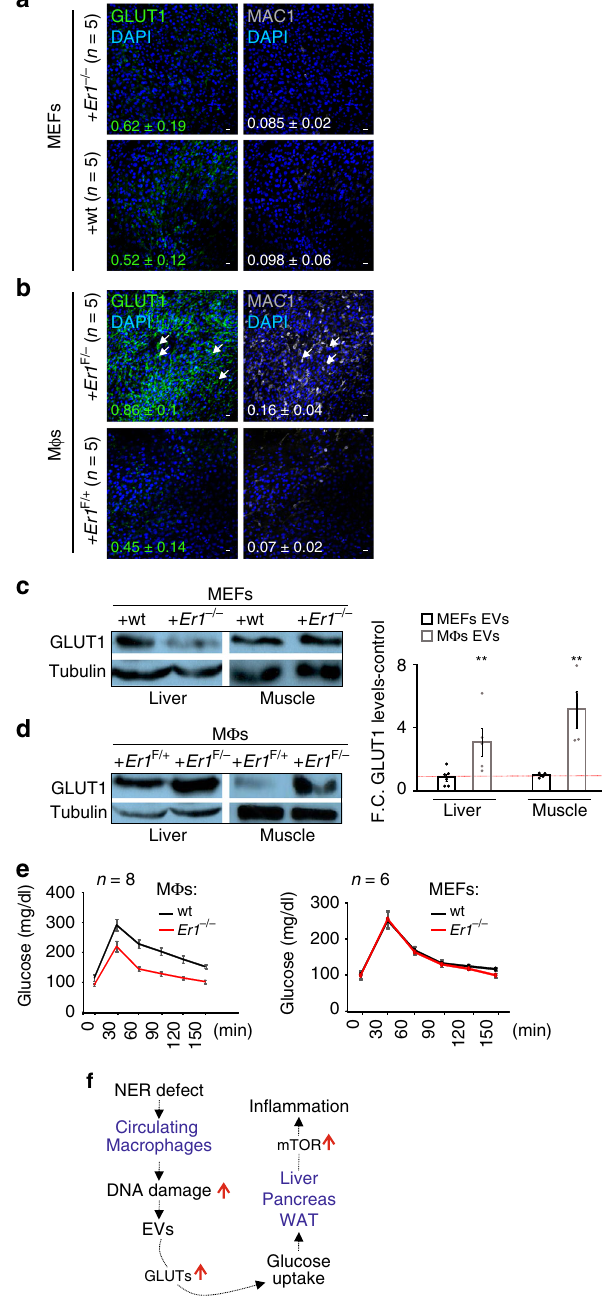
with a sequence encoding EGFP, respectively. The primers used were as follows (restriction sites are underlined): Rac1_pEGFPN1_For: GATCTCGAGATG